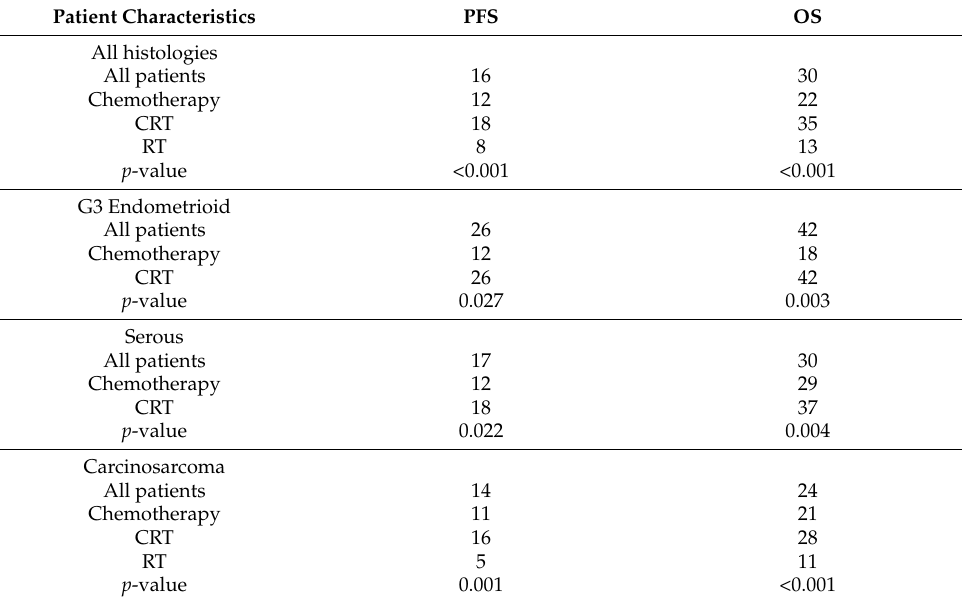
Table 2. Progression-free and overall survival based on histology and adjuvant